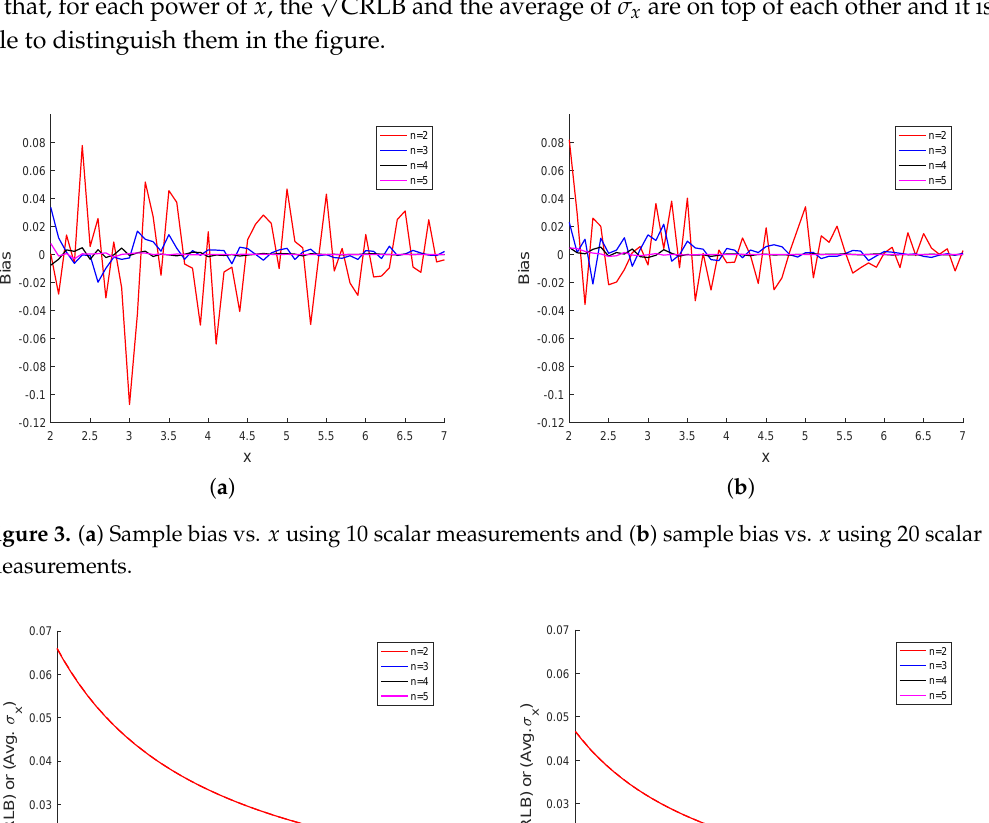
√ CRLB or (Avg. σ x ) vs.